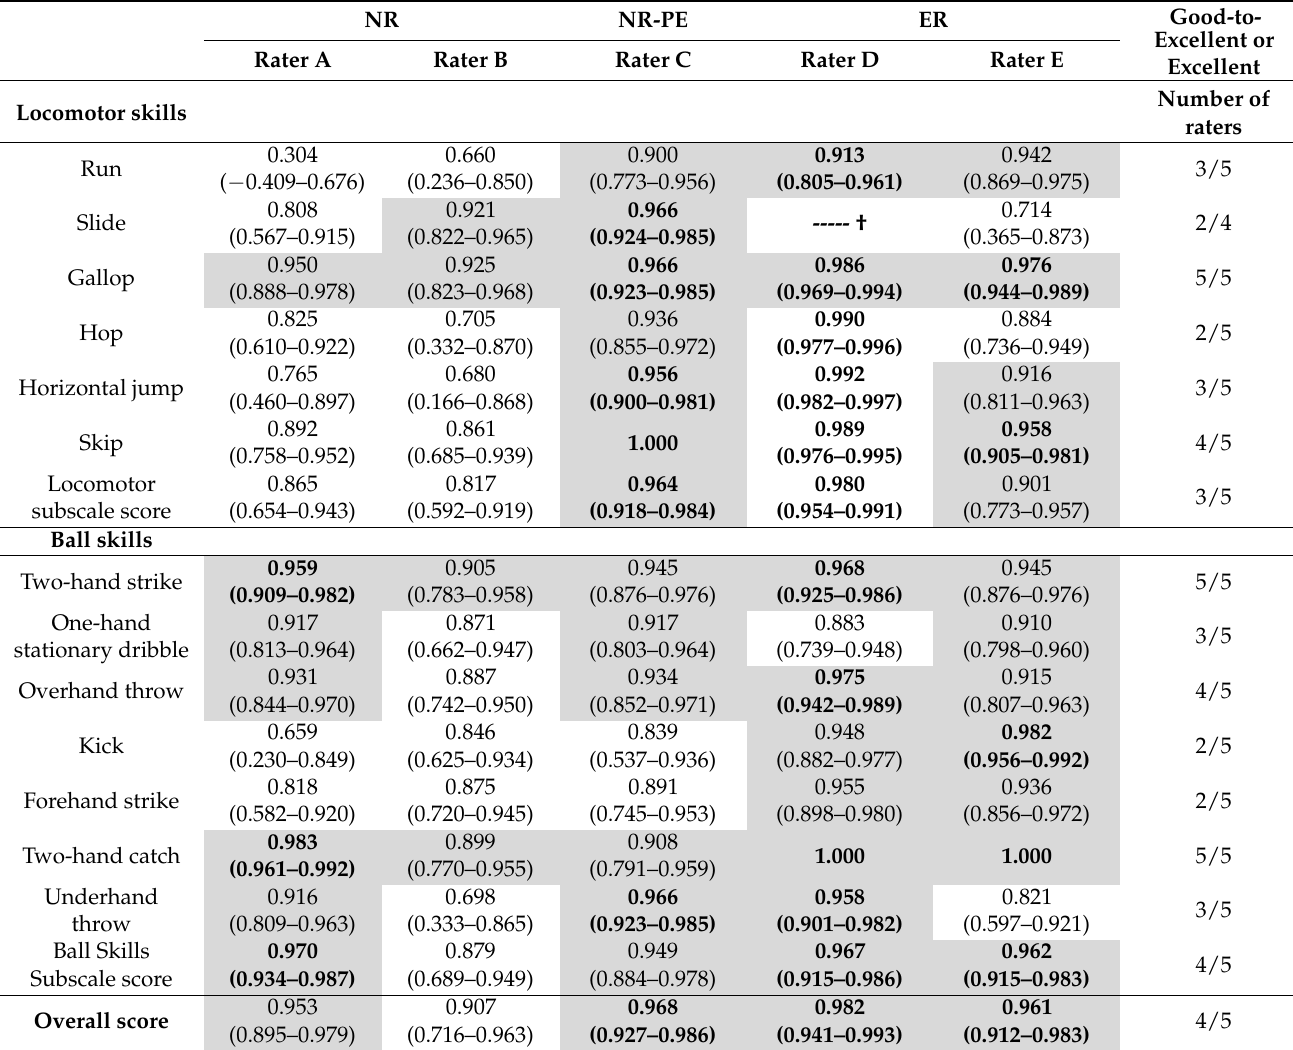
Table 1. Intra-rater reliability *: live vs. slow-motion: Subscales, skills and overall scores.